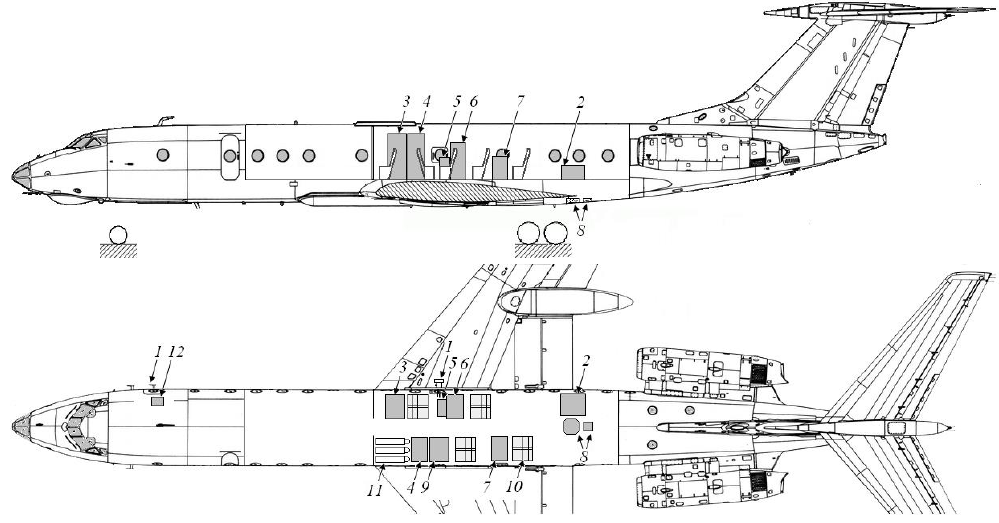
Figure 1. Arrangement of scientific equipment onboard the Tu-134 OPTIK flying laboratory: 1 – air intakes; 2 – power supply unit for airborne equipment; 3 – instrument rack for the gas analyzers: O 3 (TEI model 49C), SO 2 (T-API 100E), and DAS (diffusion aerosol spec- trometer); 4 – instrument rack for the gas analyzers: CO 2 (CONDOR), CO 2 / CH 4 / H 2 O (Picarro G2301-m), O 3 (TEI model 49C), and CO (TEI model 48C); 5 – rack for the filter-aspiration setup, laser aerosol spectrometer (Grimm model 1.109), and O 3 gas analyzer (OPTEK 3.02P) ; 6 – instrument rack for aethalometer and flow-through nephelometer (FAN); 7 – rack for the central onboard computer; 8 – camera windows; 9 – instrument rack for the CO 2 gas analyzer (LI-6262) and portal of air sampling into flasks; 10 – operator chairs; 11 – span gas cylinders; 12 – device for sampling onto filters for analysis of the organic component of